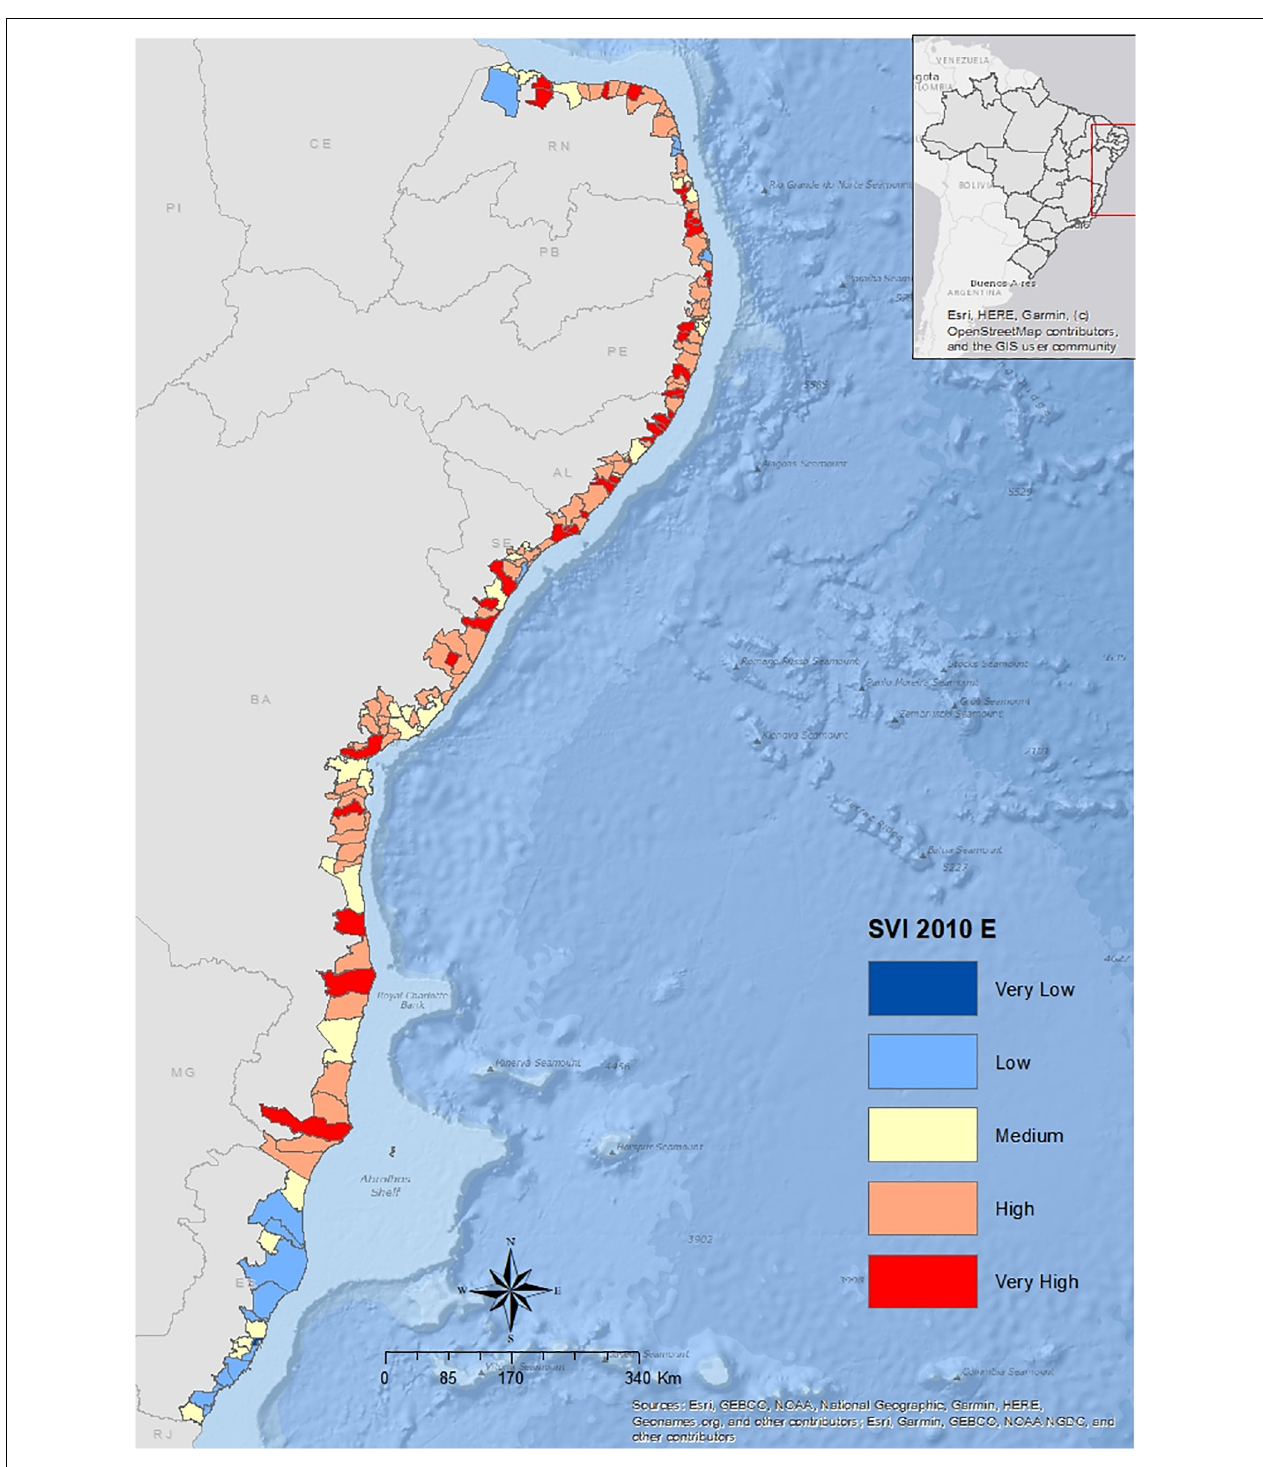
FIGURE 9 | SVI for the East coast municipalities. Elaborated by the authors with data from IPEA (2020a).